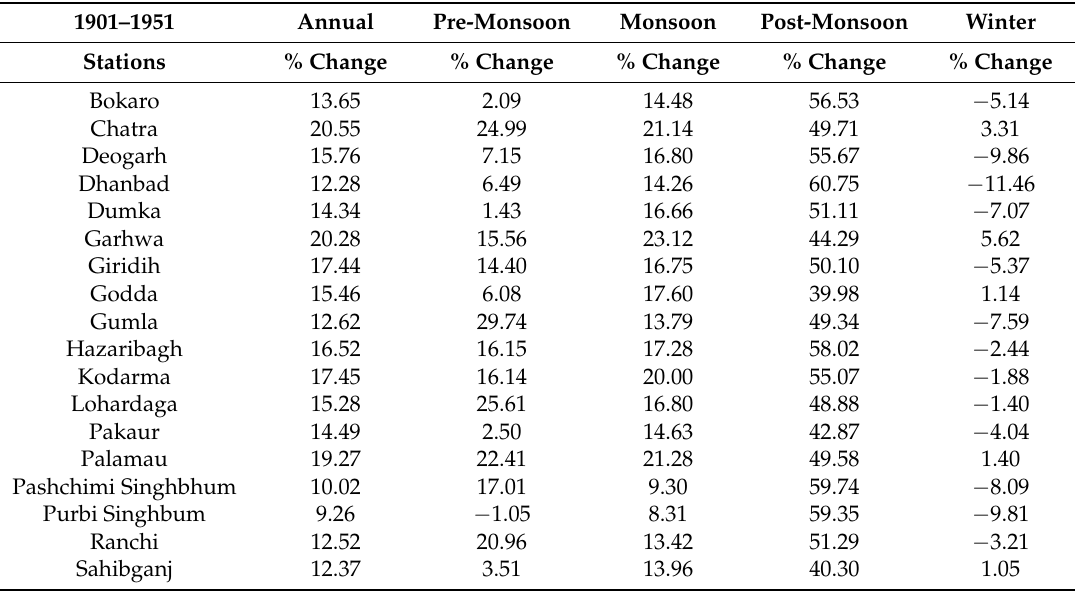
Table 4. Percent change of Annual and Seasonal rainfall (1901–1951).